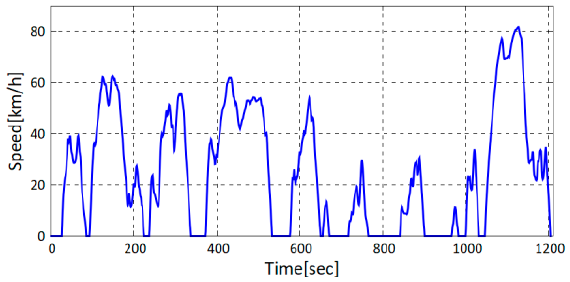
Figure 6. Driving pattern of JC08 mode. Table 2. Specifications of 10–15 mode and JC08